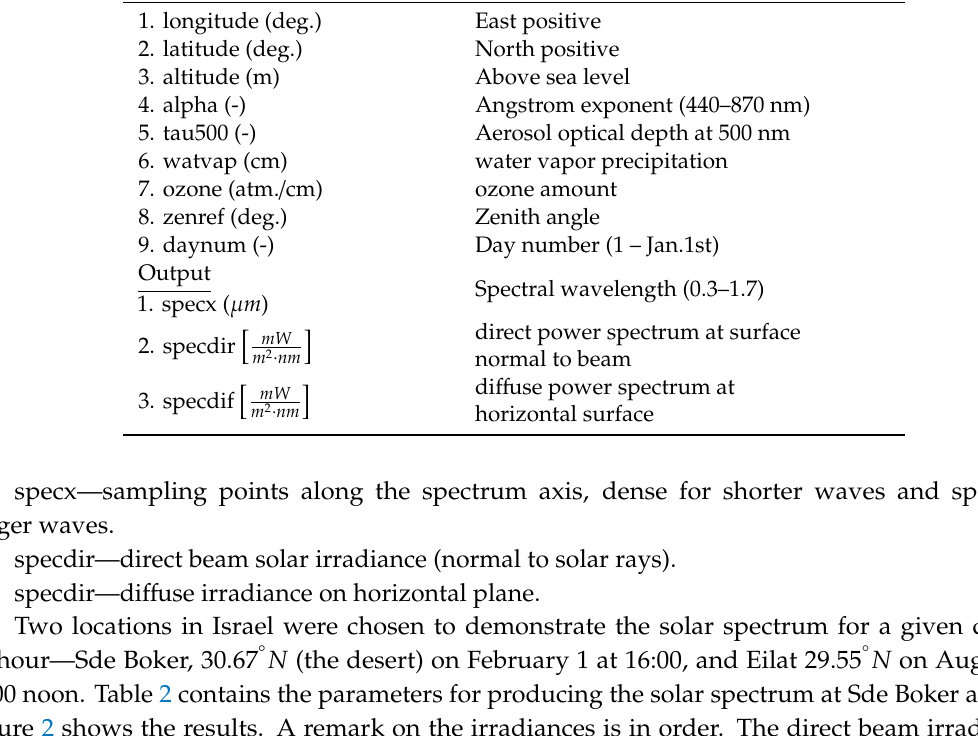
Table 1. SPECTRAL(2)